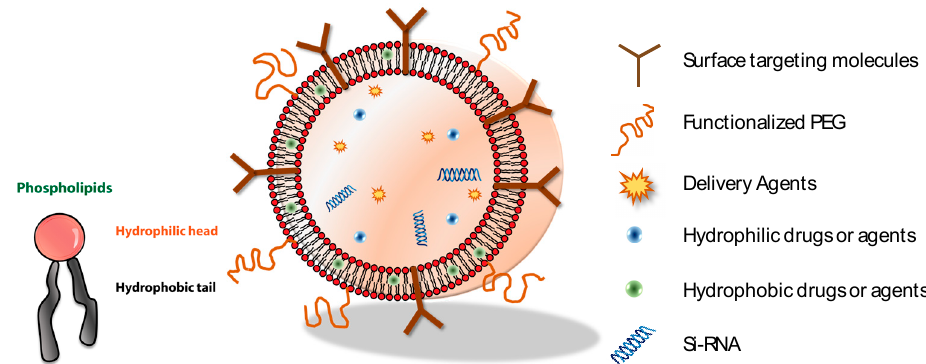
Figure 1. The schematic of the self-assembly of a core-shell structure (i.e., vesicles) consists of amphiphilic molecules and a variety of biological moieties and agents. One of the representative amphiphilic molecules, phospholipids, is composed of hydrophilic heads and hydrophobic tails.